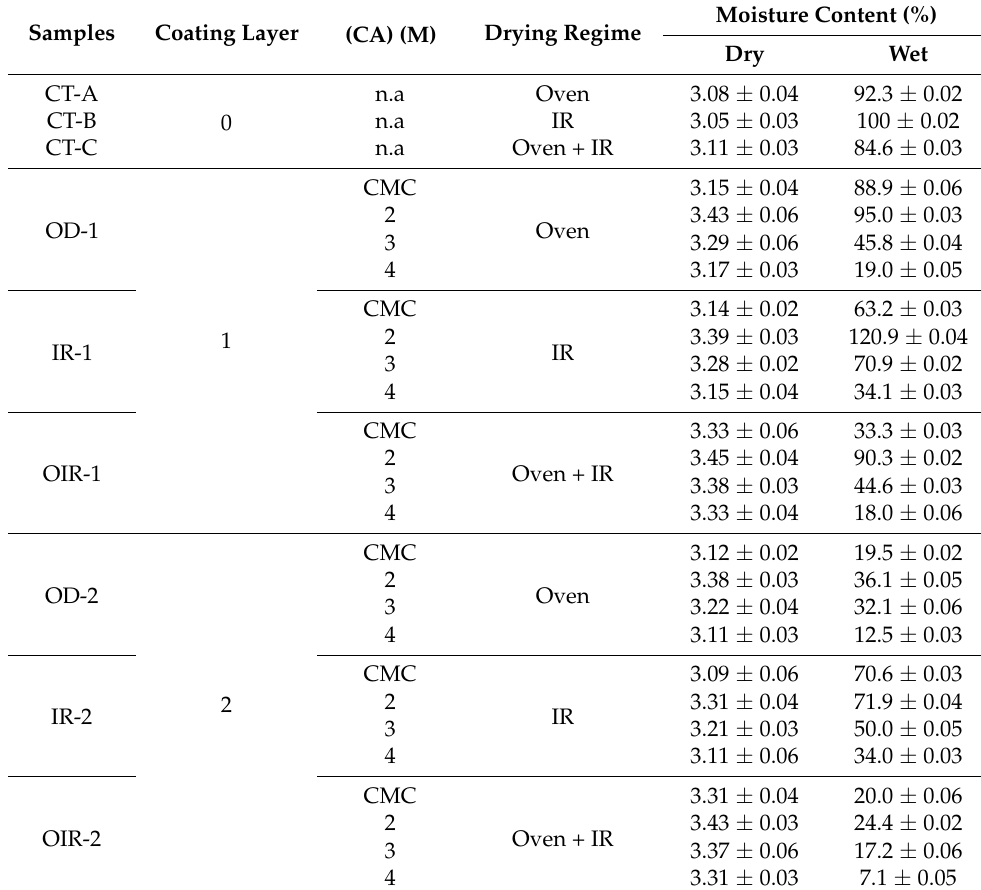
Table 4. Moisture content (%) of CMC cross-linked with different concentrations of CA-coated cotton thread